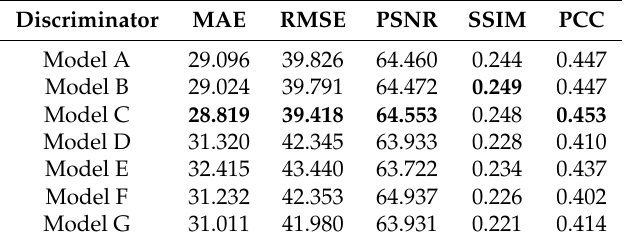
Table 7. Analysis of the discriminator architecture. The best scores are displayed in bold.